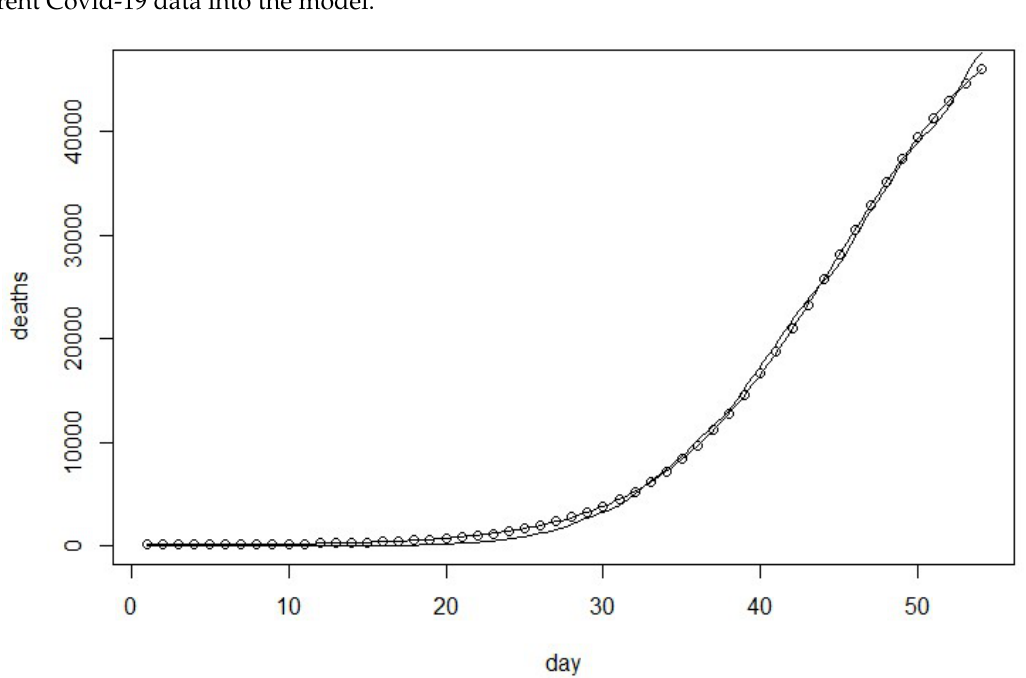
Figure 2. The estimated cumulative number of deaths vs. actual death data from Model 2.